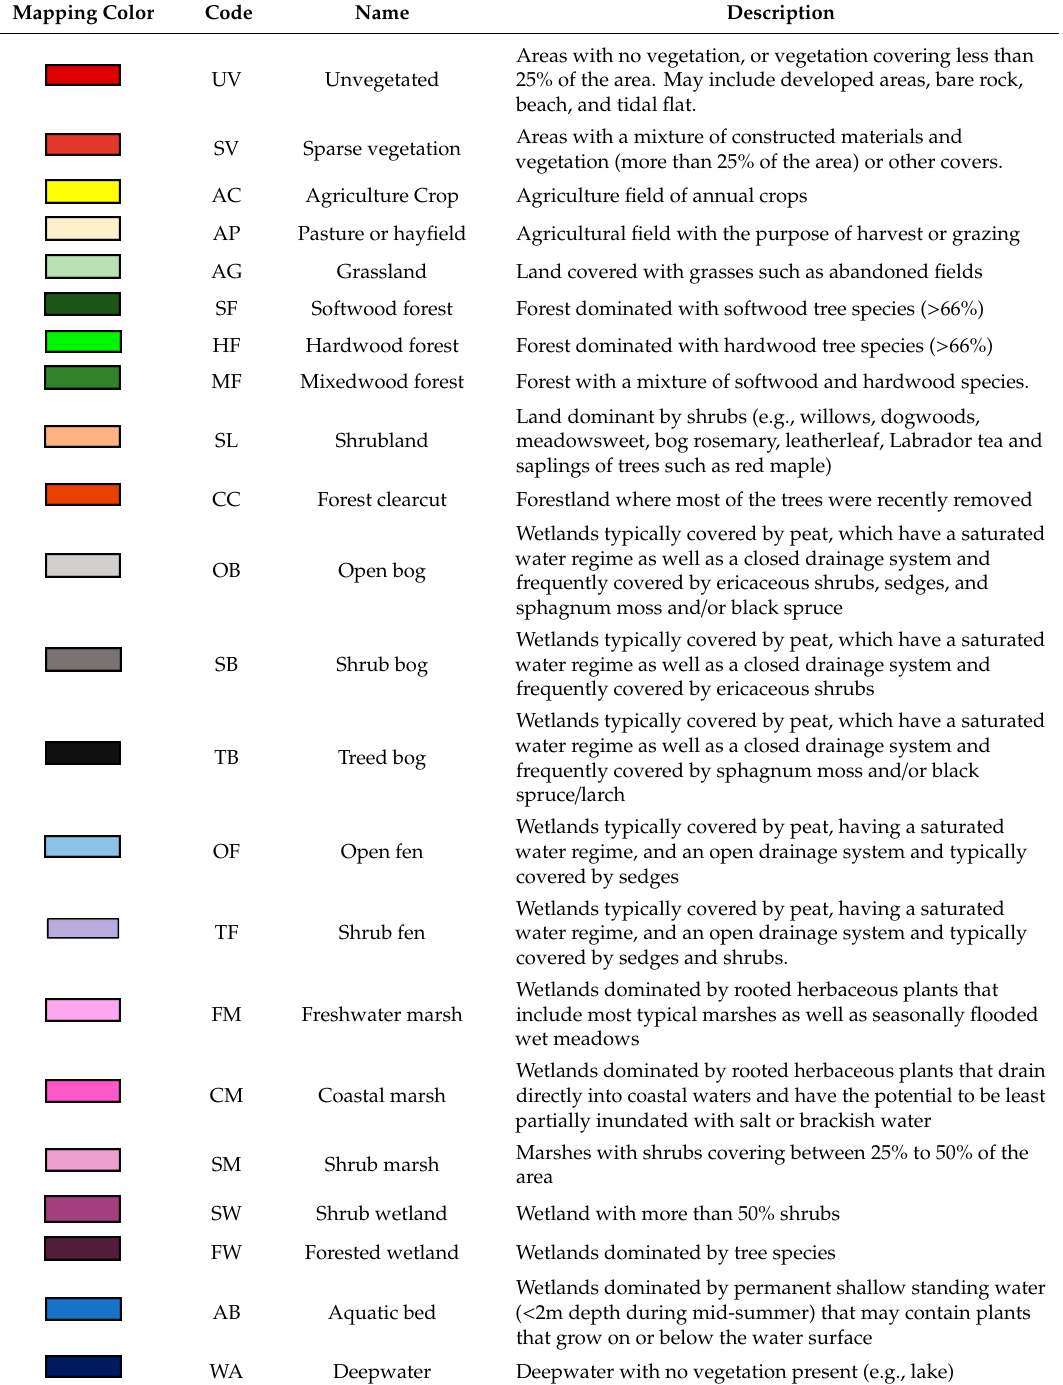
Table 6. Name and description of each landcover class used in this study with its corresponding mapping color and class code.